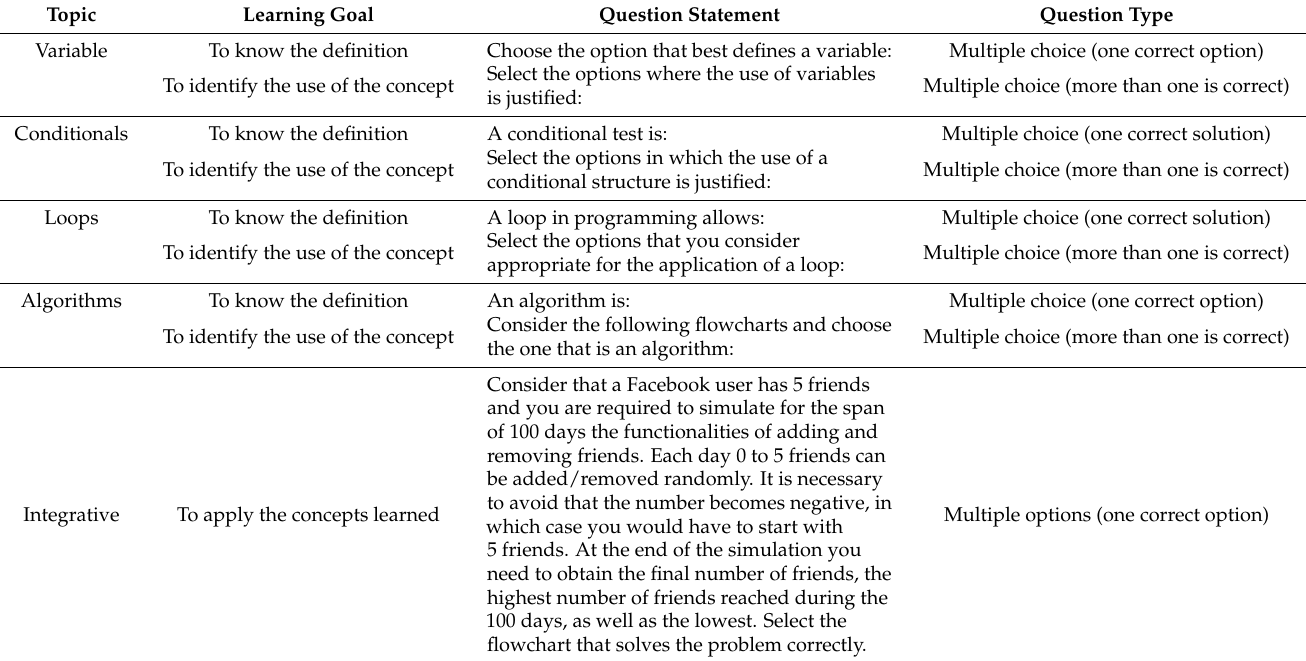
Table A1. Structure of the midterm exam administered to the students. Each question was evaluated with a score of 10